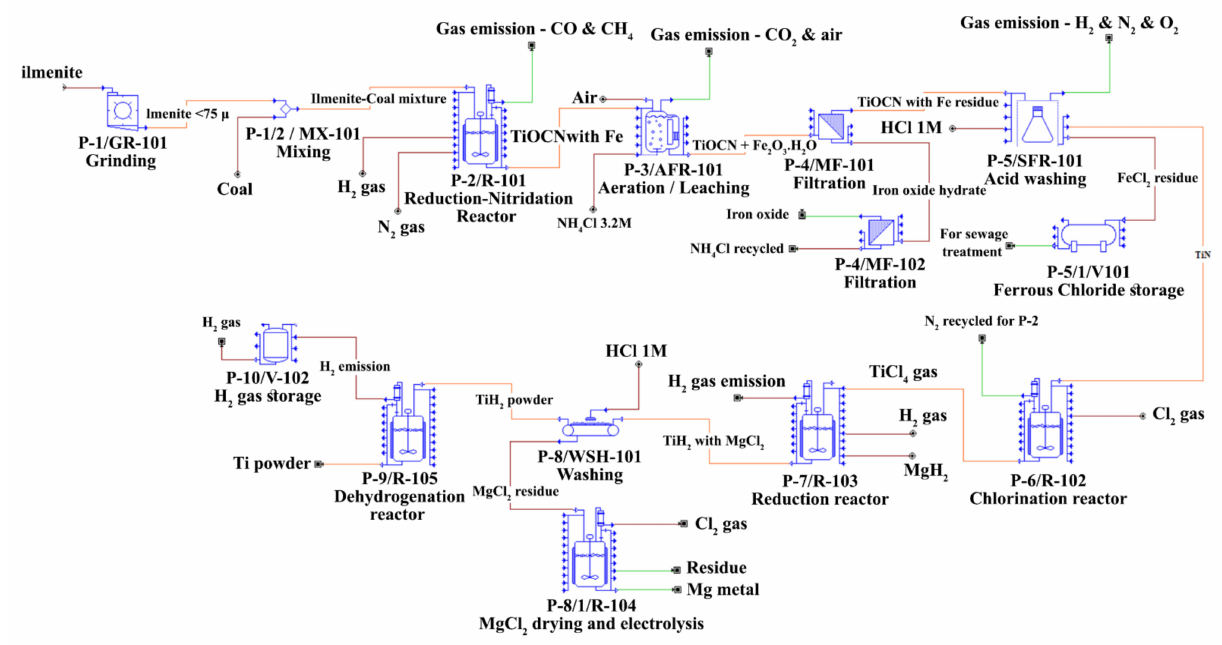
Figure 9. Simulation flowsheet for titanium powder production in SuperPro